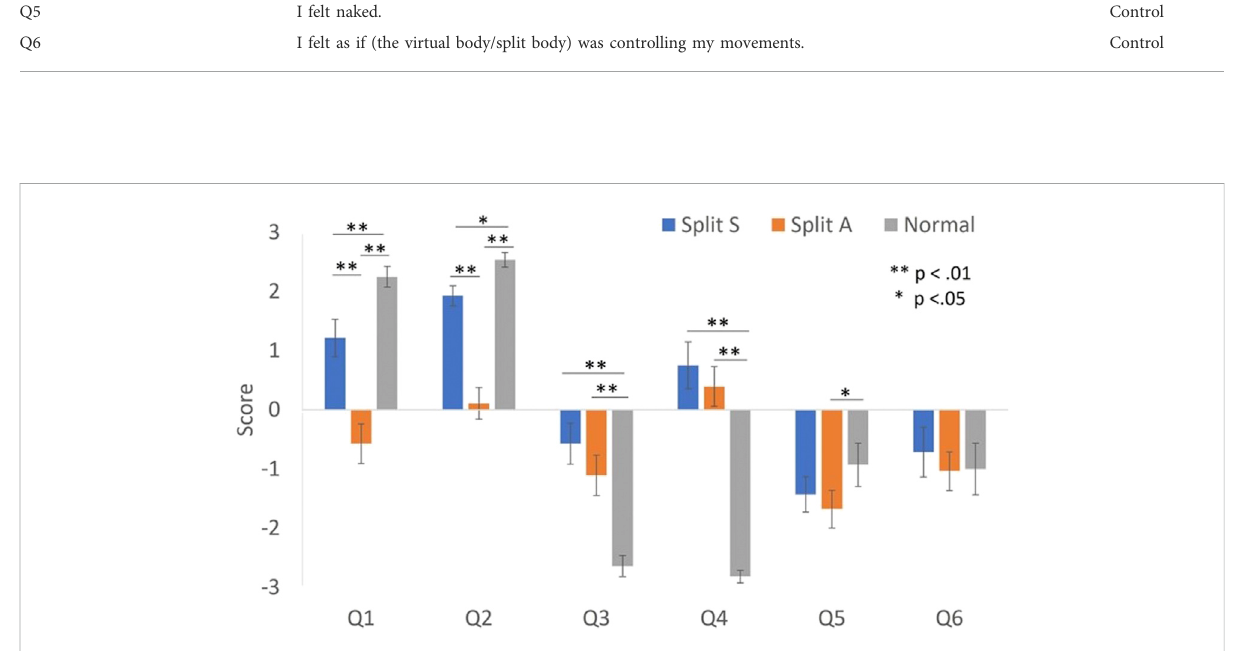
FIGURE 4 Questionnaire results; the error bars indicate